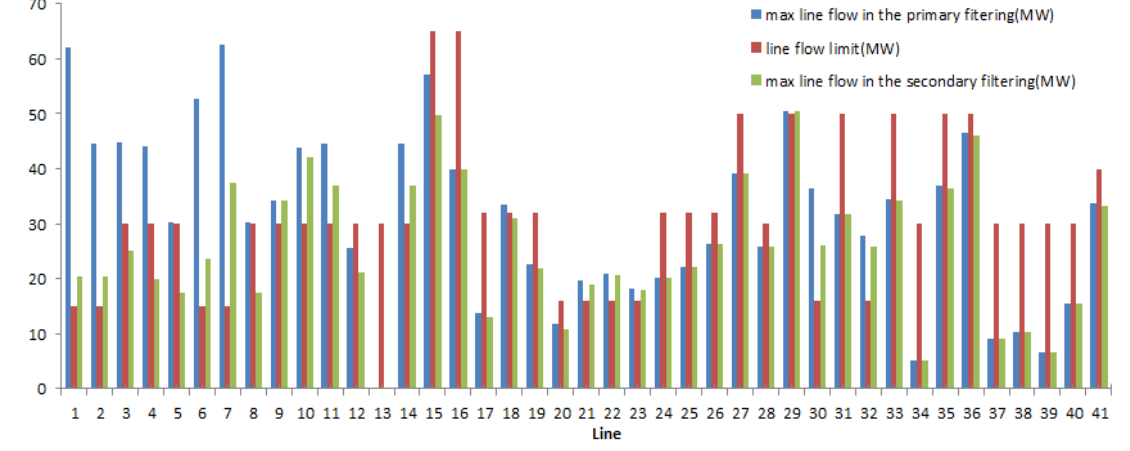
Figure 4. Maximum line flows in the primary and secondary filtering phases.